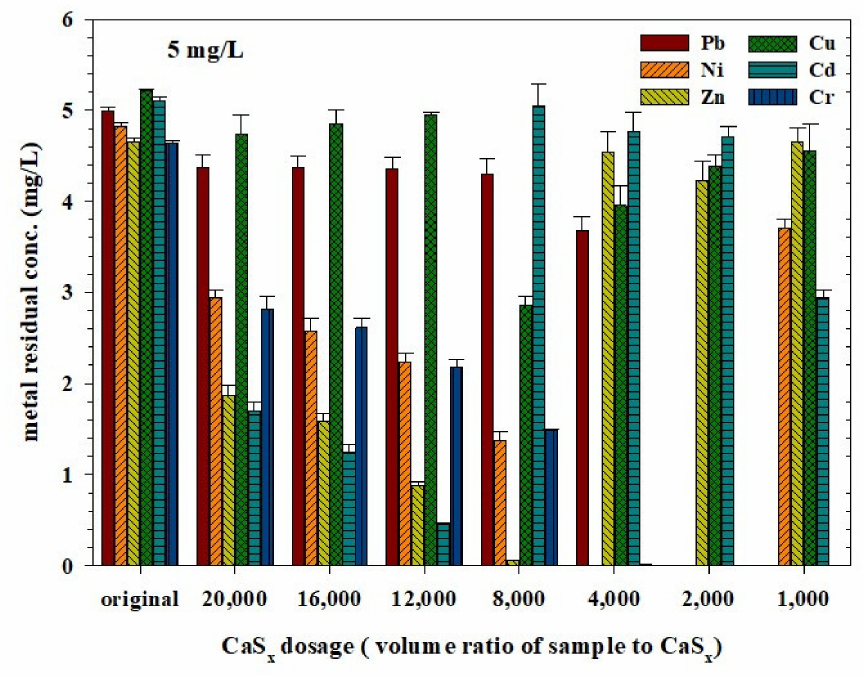
Figure 5. The removal efficiency of calcium polysulfide on various metals at low concentrations (5